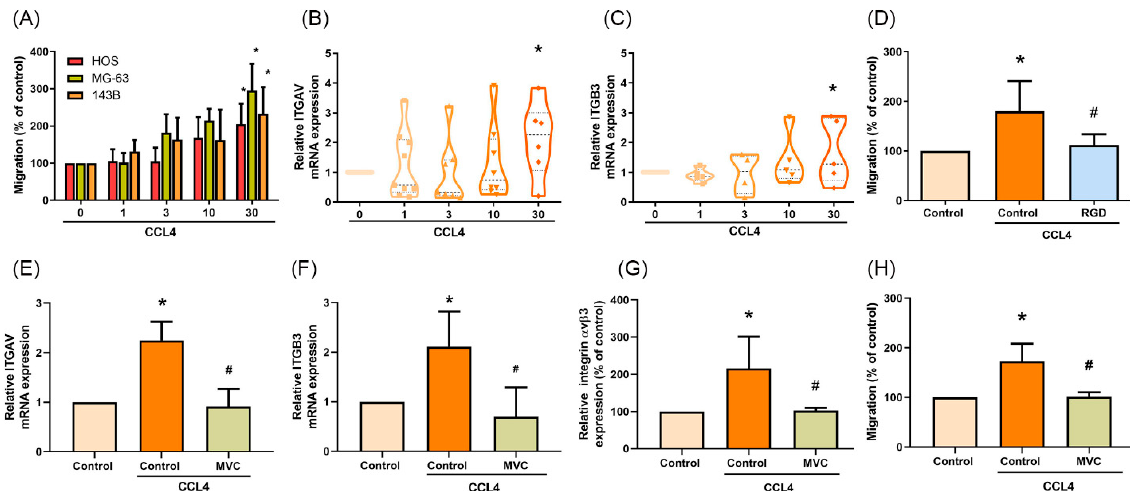
Figure 3. CCL4 promotes integrin α v β 3 expression and cell migration through the CCR5 receptor. ( A ) Cells were incubated with different concentrations of CCL4 (0–30 ng/mL) for 24 h, then cell migration ability was examined by the Transwell assay. ( B , C ) 143B cells were incubated with different concentrations of CCL4 (0–30 ng/mL) for 24 h, then mRNA expression of integrin α v (ITGAV) and β 3 (ITGB3) was examined by qPCR. ( D ) 143B cells were treated with specific α v β 3-blocking peptide (RGD; 100 nM) for 30 min and then stimulated with CCL4 (30 ng/mL) for 24 h. Cell migration ability was examined by the Transwell assay. ( E – H ) 143B cells were treated with a CCR5 antagonist (maraviroc, MVC; 5 uM) for 30 min then stimulated with CCL4 (30 ng/mL) for 24 h. Levels of ITGAV ( E ) and ITGB3 ( F ) mRNA expression, cell surface integrin α v β 3 protein expression ( G ), as well as cell migratory abilities ( H ) were examined by qPCR, flow cytometry, and the Transwell assay, respectively. The results were obtained from three independent experiments and are expressed as the means ± SD. * p < 0.05 compared with controls; # p < 0.05 compared with CCL4-treated controls.